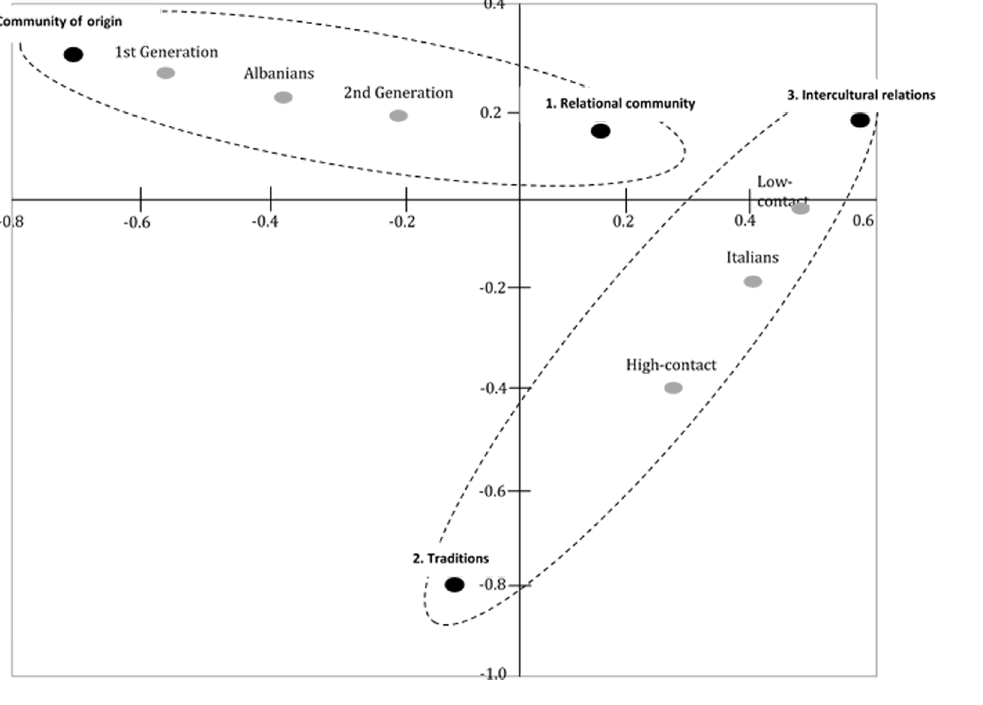
Figure 1. Correspondence analysis on words x clusters